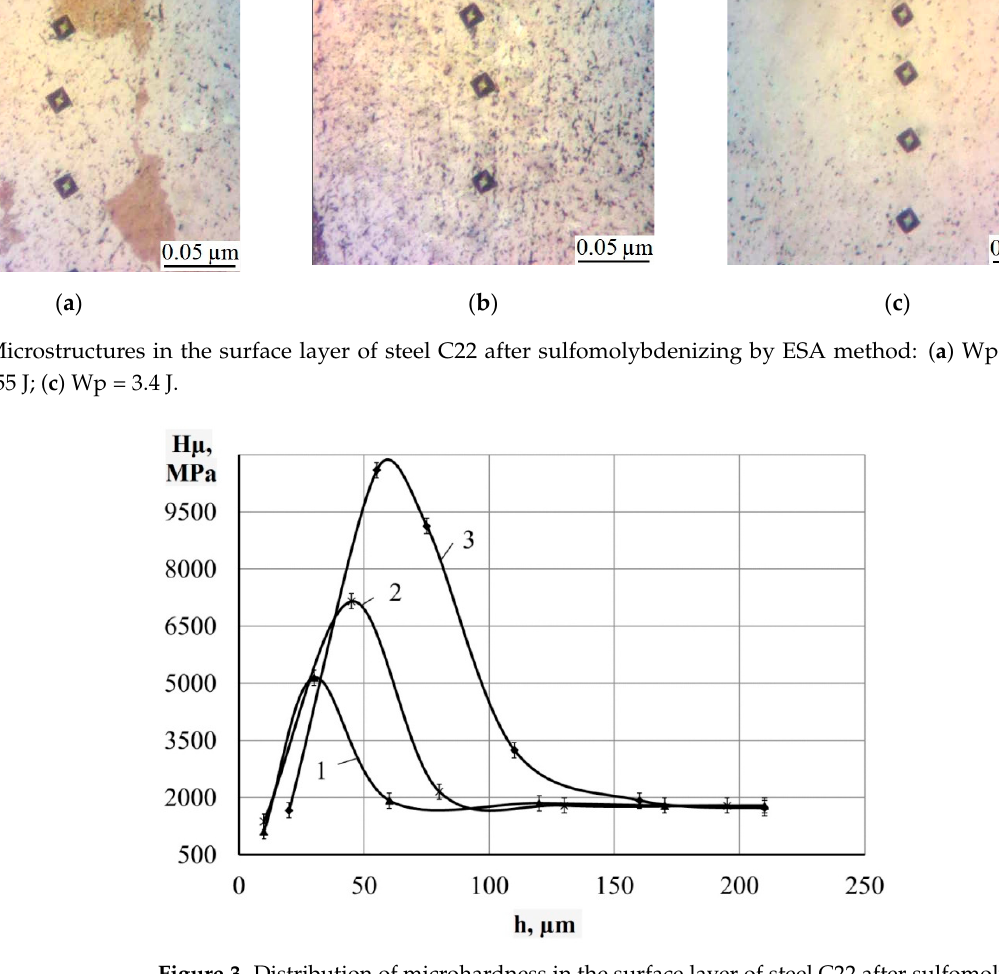
( c ) Figure 4. Microstructures in the surface layer of steel C40 after sulfomolybdenizing by ESA method: ( a ) Wp = 0.13 J; ( b ) Wp = 0.55 J; ( c ) Wp = 3.4 J.